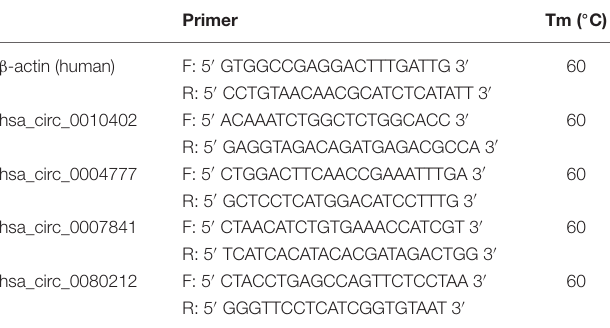
TABLE 1 | Primers designed for qRT-PCR validation of candidate circRNAs.